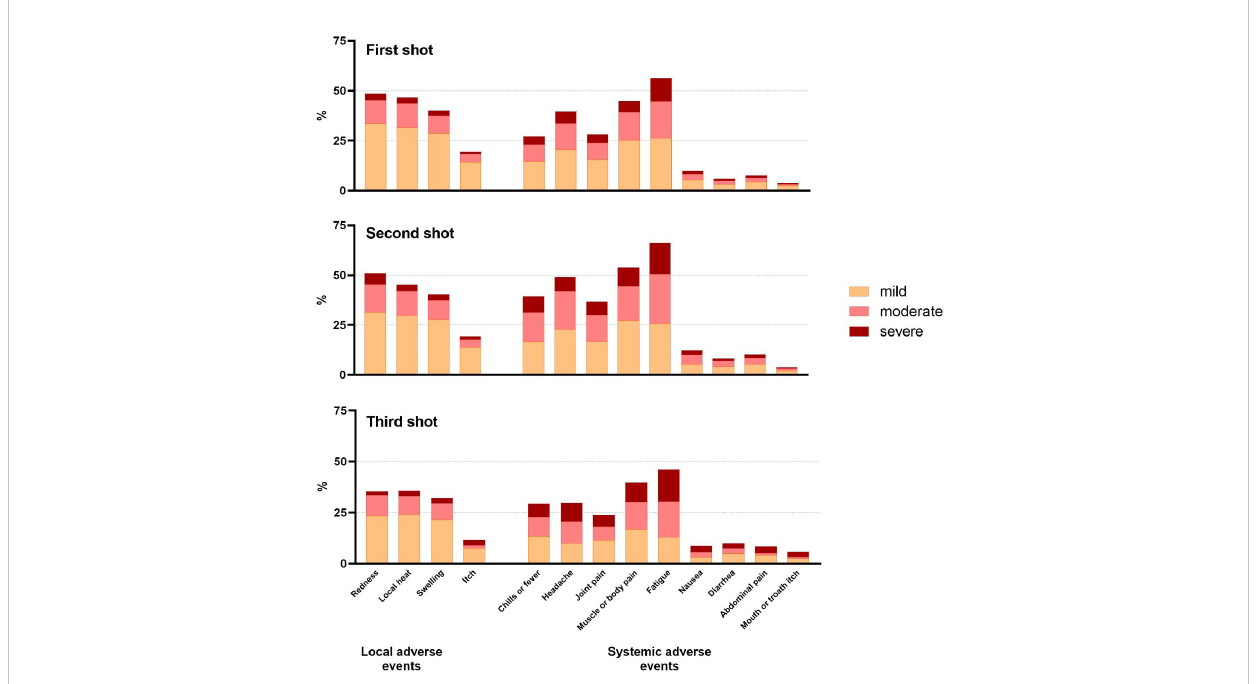
FIGURE 4 Percentages of patients with PID reporting local and systemic adverse events after COVID-19